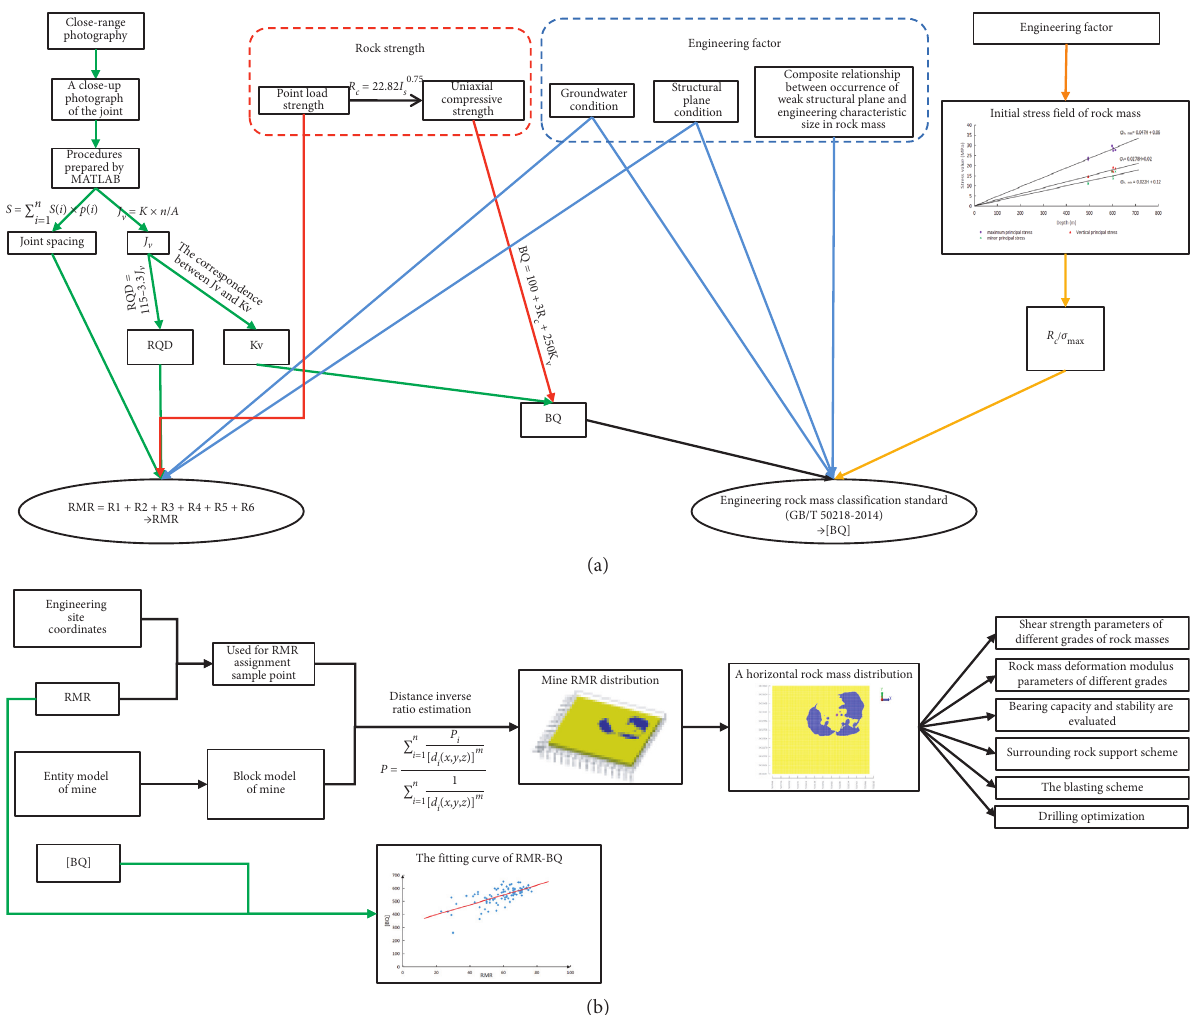
Figure 1: Overview of 3D visual rock mass quality evaluation method and system based on close-up photography: (a) the first part and (b) the second